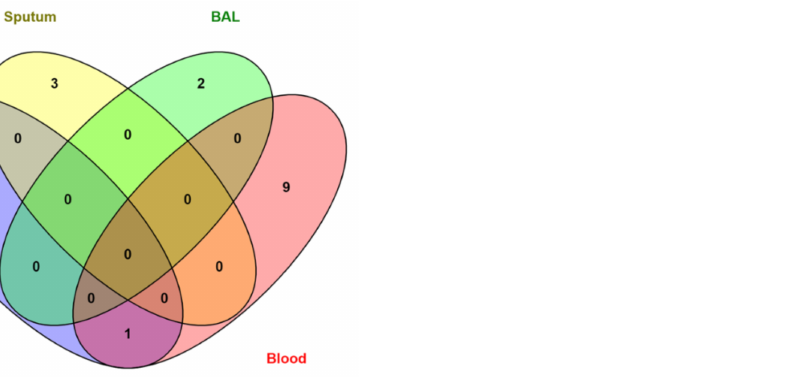
Figure 3. Distribution of diagnostic miRNAs for asthma among different tissues (BAL, BEC, Sputum, EBC, and